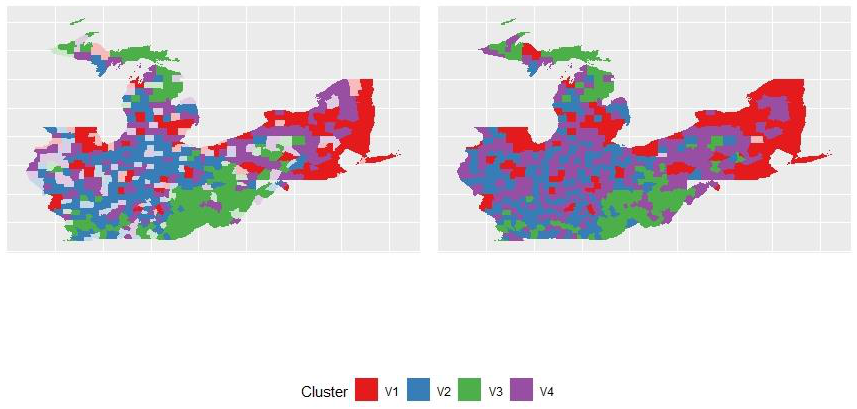
Figure 2. FCM and GFCM clusters.